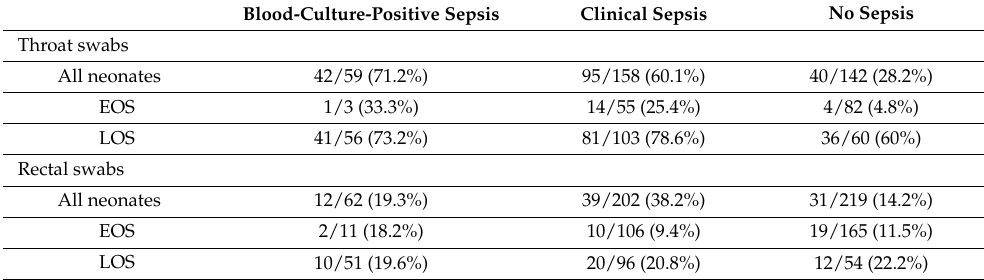
Table 2. Rates of detecting target organisms in screening swabs.